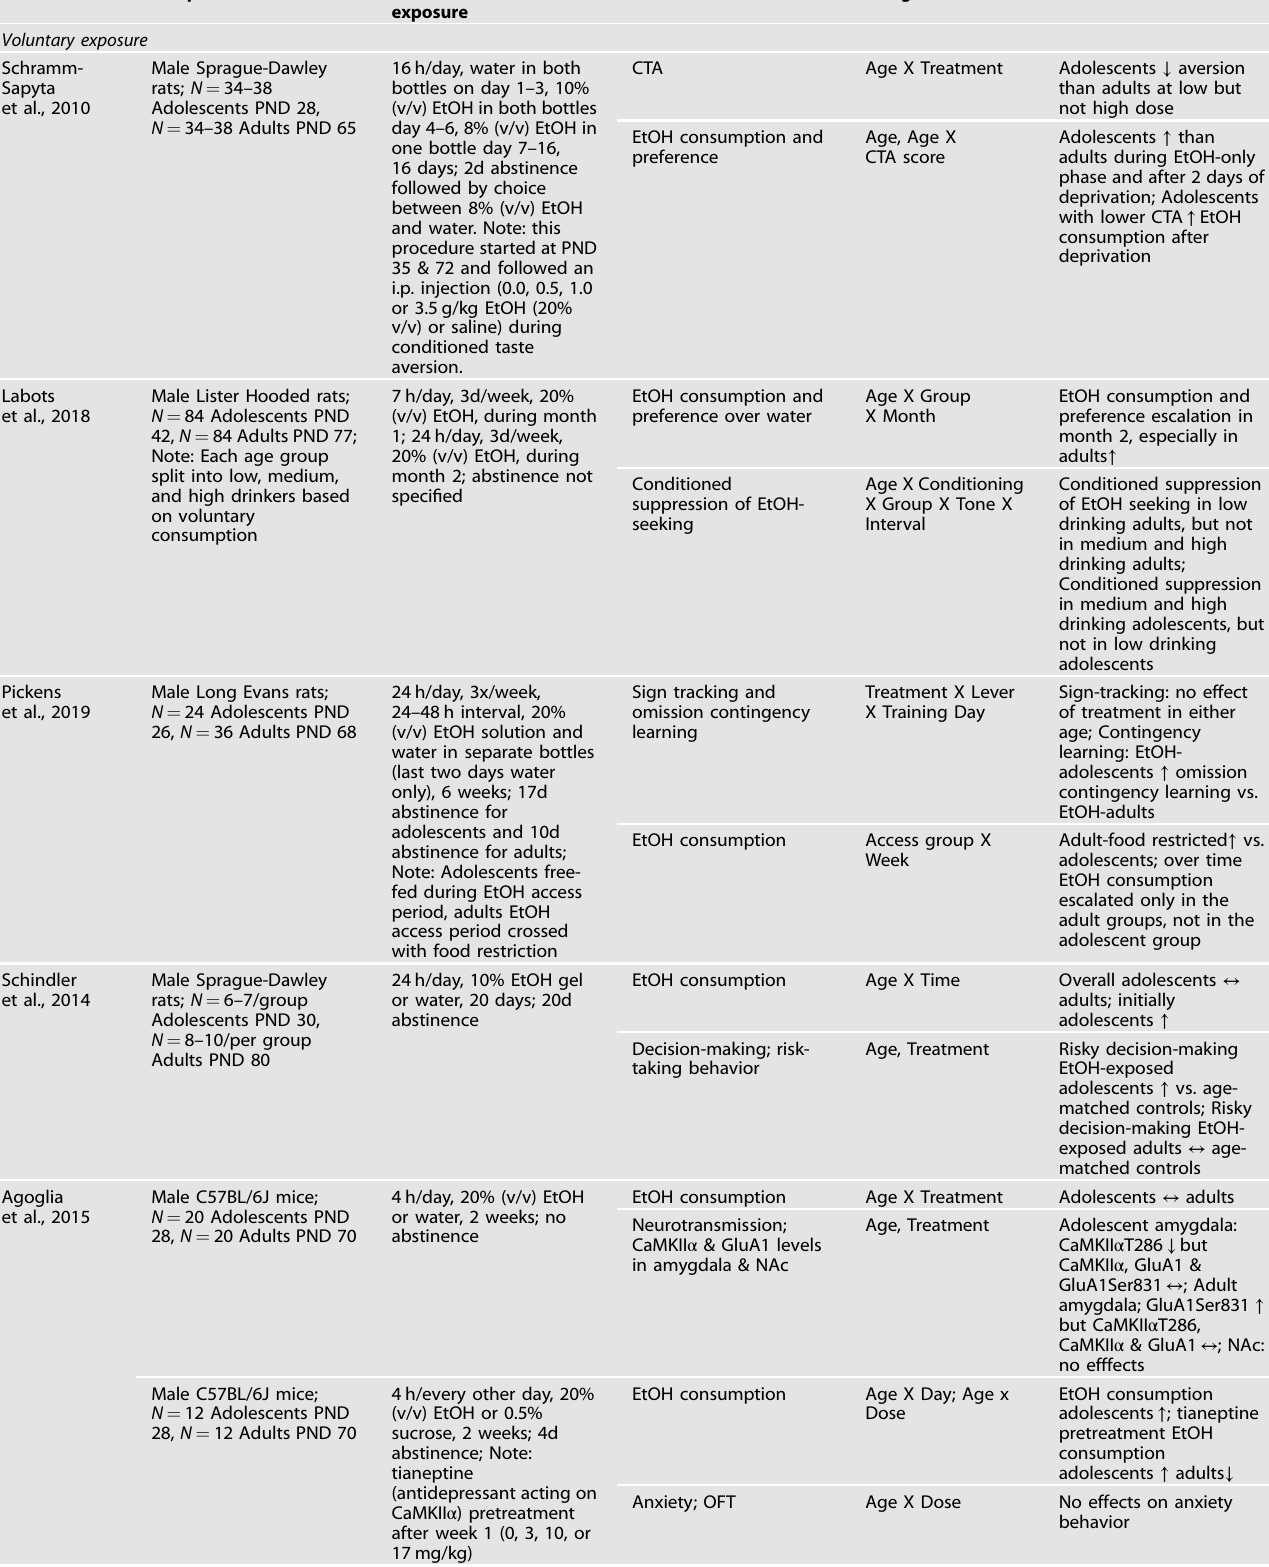
Table 1. Characteristics and fi ndings of animal studies on age-related differences on the effect of alcohol on cognition and the